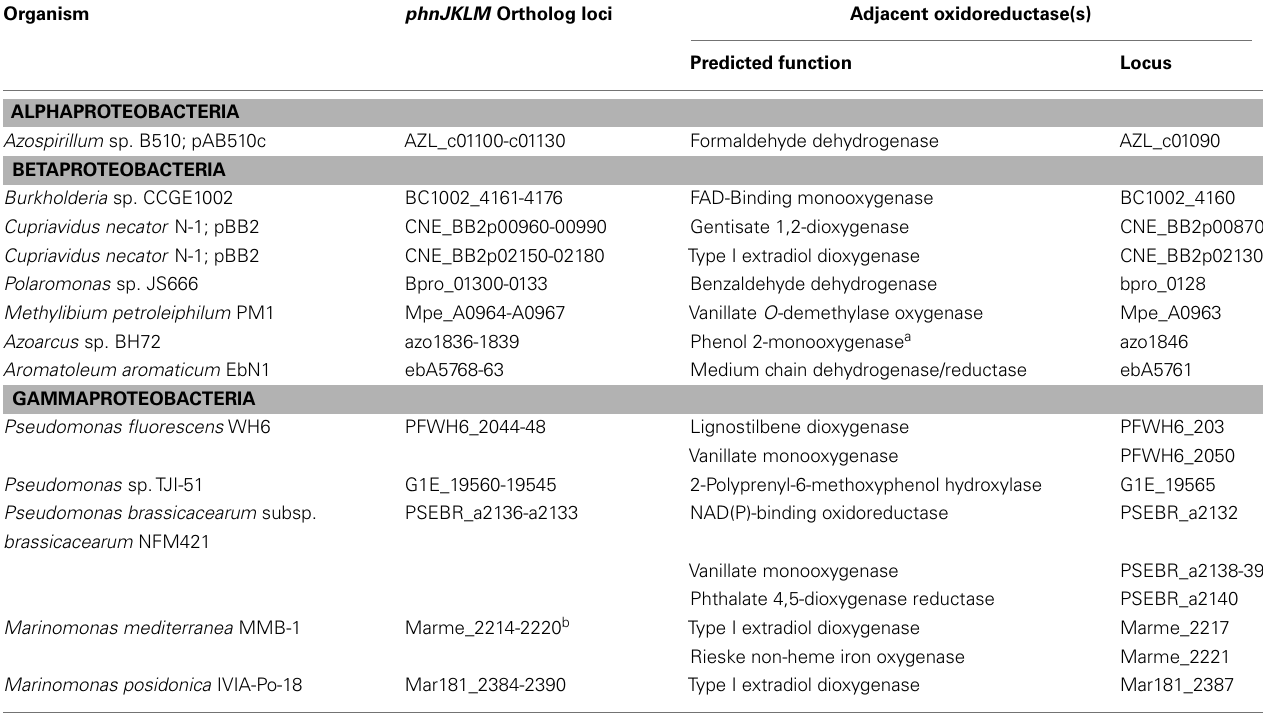
Table 1 | Examples of phnJKLM orthologs and adjacent oxidoreductase genes.